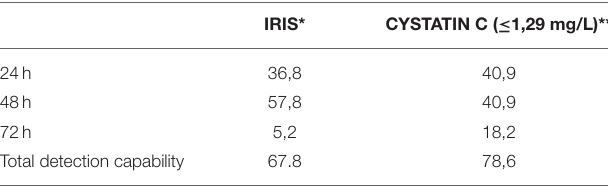
TABLE 1 | Percentage of detection of acute kidney injury (AKI) using the criteria proposed by the IRIS (12) and through the serum concentration of cystatin C in dogs during their stay in the intensive critical unit (ICU) of the Veterinary Hospital of the Federal University of Minas Gerais